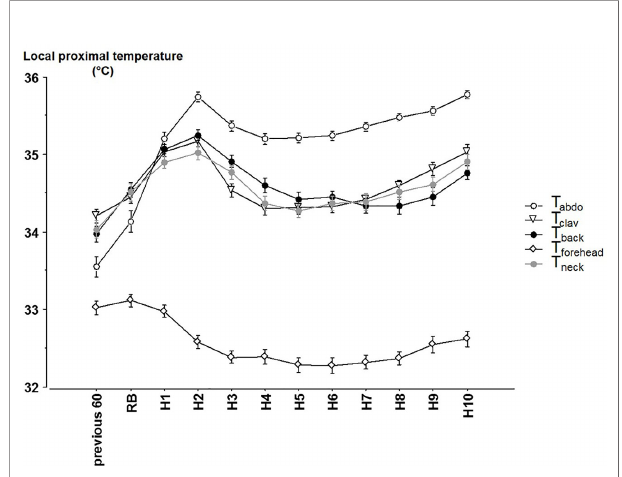
FIGURE 2 | The different local proximal skin temperatures (mean ± SEM) from 60 min before reported bedtime, at reported bedtime (RB) and at hourly timepoints after reported bedtime. abdo: abdominal Temperature, clav: average of the right and left clavicular temperatures. Previous 60 = during the 60 min before reported bedtime (RB), H1 to H10 hours in